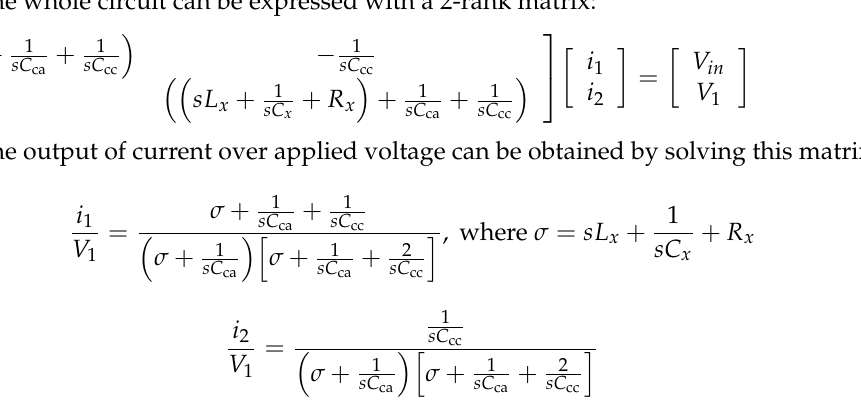
Figure 3. ( a ) Equivalent electrical circuit; ( b ) a simplified version of the circuit.